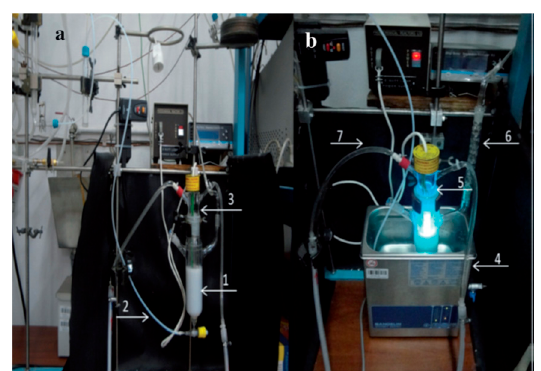
Figure 9. Sonophotodeposition setup before ( a ) and during the deposition procedure ( b ): (1) batch photoreactor; (2) argon line; (3) switched off 6 W UV lamp; (4) ultrasonic bath; (5) switched on 6W UV lamp; (6) reflux condenser; and (7) lamp cooling system (20 °C). Figure from [141], Copyright 2015, John Wiley and